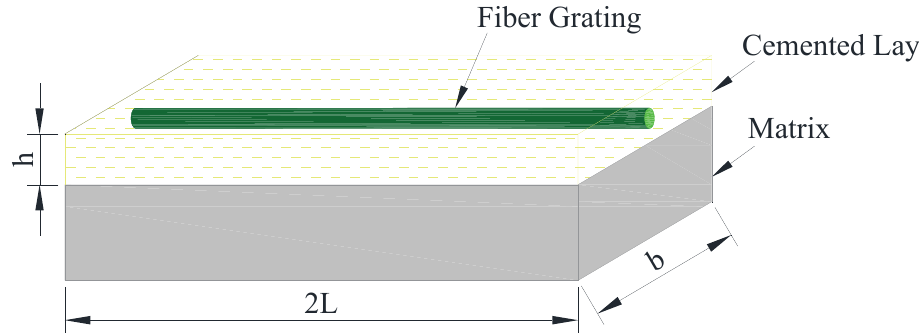
Figure 1. Schematic diagram of bare fiber grating sticking on the substrate surface. Taking the microcells with any length of dx on the FBG sensor, the strain transfer relationship between the different media of the microcell media is shown in Figure